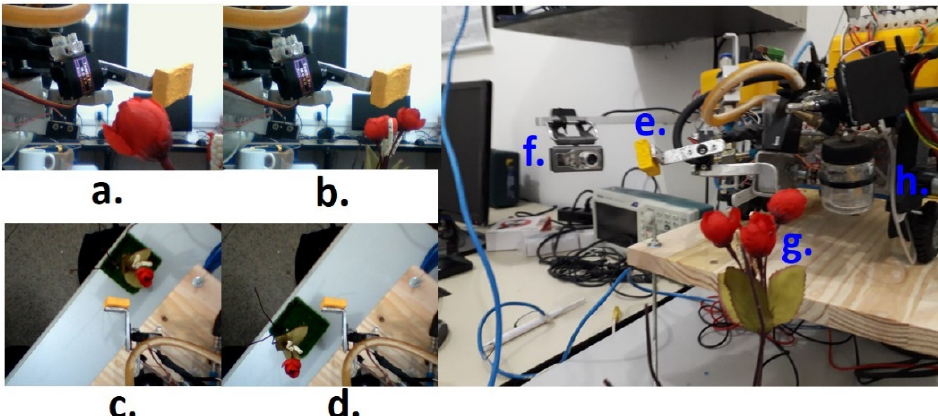
Figure 7. Prototype of the probing robot bio-inspired in the licking systems of the bees. ( a ) Distance from target to camera less than focal length; ( b ) Distance from target to camera greater than focal length; ( c ) Sweep angle −𝛿 ; ( d ) Sweep angle +𝛿 ; ( e ) Probe; ( f ) Lateral camera; ( g ) Flower or target; ( h ) Mechanical structure of the rover.